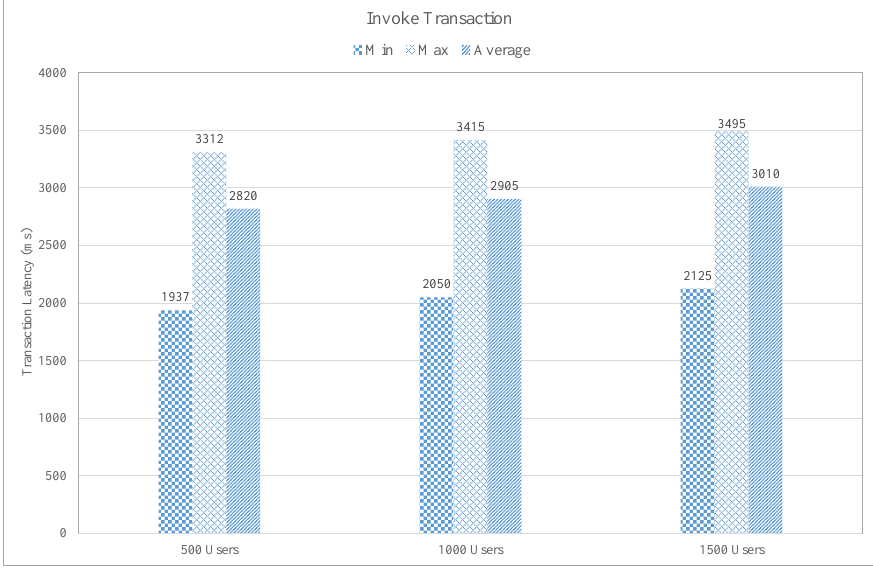
Figure 13. Invoke Transaction